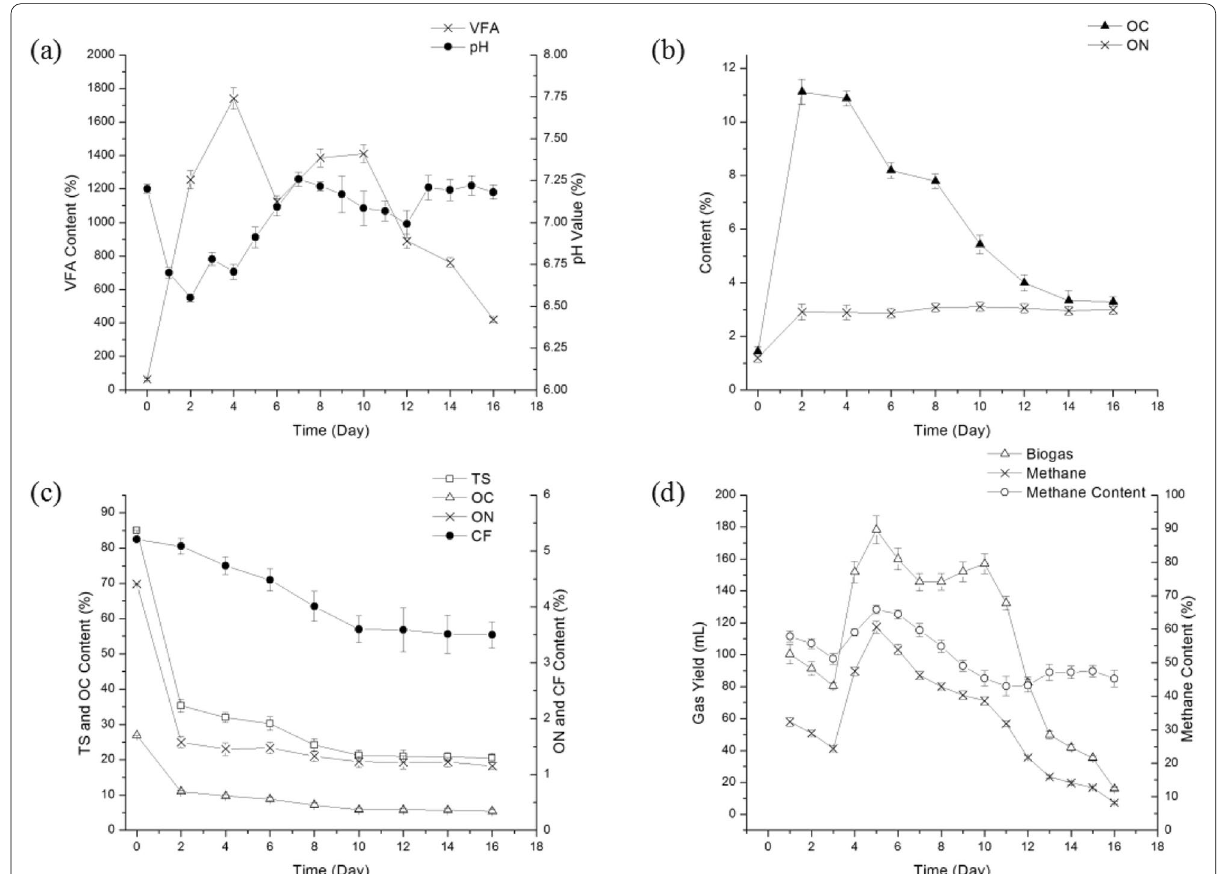
Fig. 2 Variations of typical chemical properties in biogas fermentation process. a VFAs content substrate and pH value of substrate; b OC and ON content in slurry; c TS, OC, ON and CF content in residue; d biogas, methane and methane content in reactor. The definition of abbreviations: VFAs, volatile fatty acids; OC, organic carbon; ON, organic nitrogen; TS, total solid; CF, crude